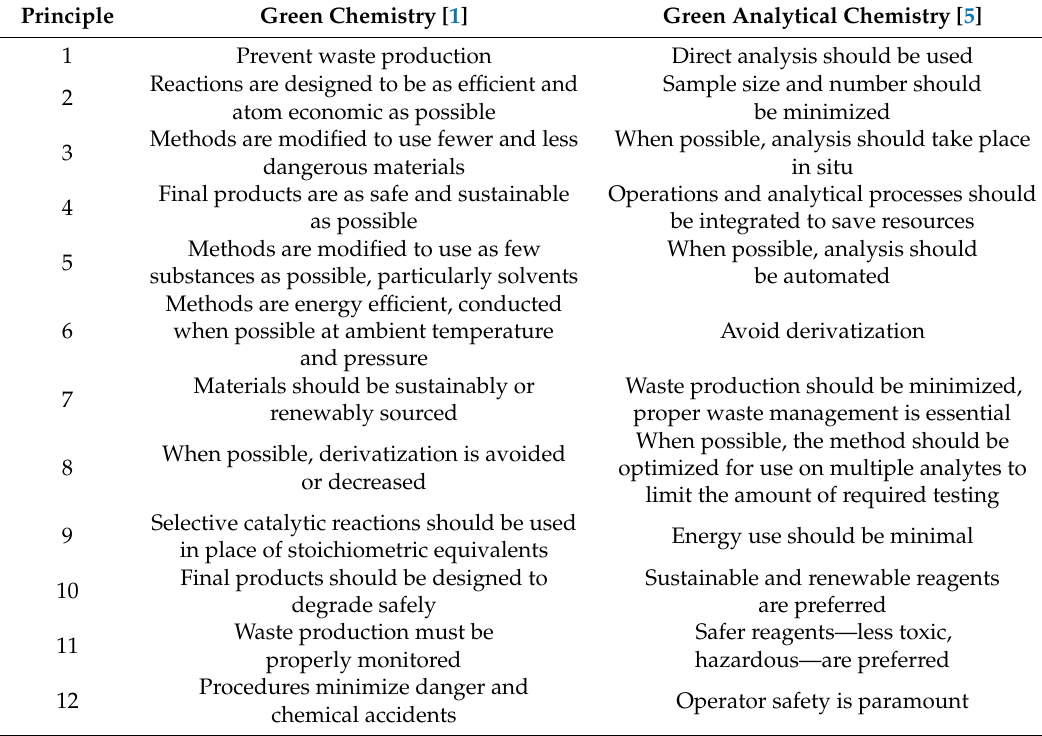
Table 1. 12 Principles of Green Chemistry and Green Analytical